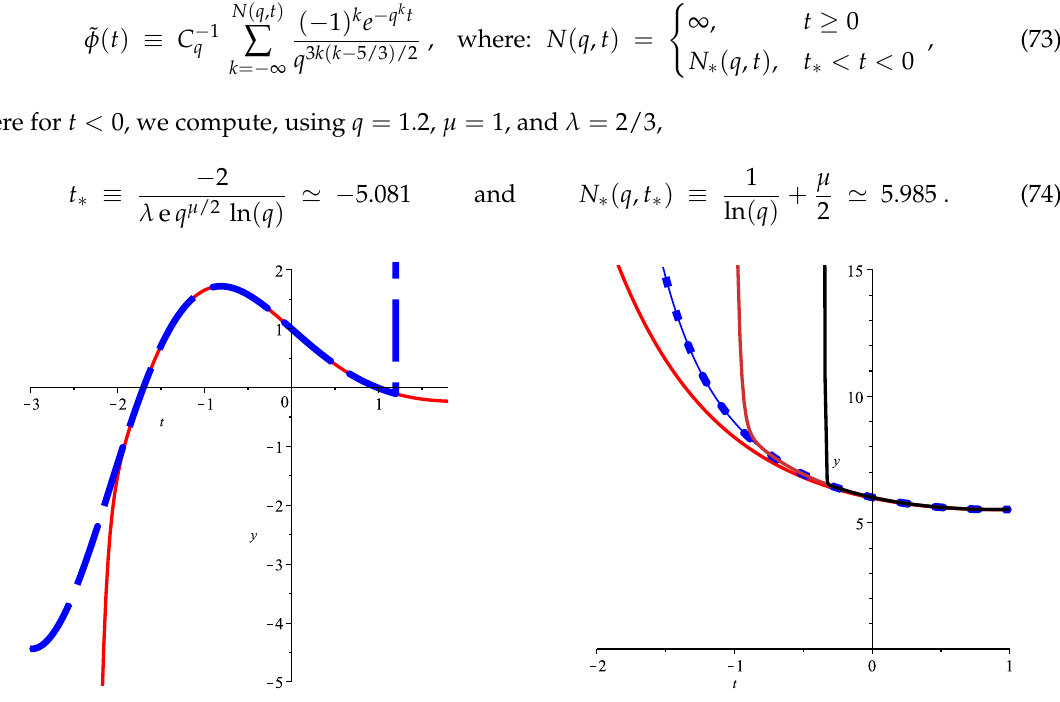
Figure 2. ( Left ) Asymptotic extension ˜ φ ( t ) from Equation (73) for φ ( t ) (solid red) together with a similarly constructed asymptotic extension for − χ ( − ∞ ,0 ] ( t ) W 1,5/3 ( t ) / f (cid:48) q = 1.2. ( Right ) Plots of e t ˜ K ( t ) where the functions ˜ K ( t ) are defined in Equation (76) for q = 1.2. Failure of the asymptotic extension is found to be around t = − 1, as compared to the computed value of t ∗ = − 1.8. The upper-sum limits, from left to right, are N ∗ = 6,10 ( dotted ) ,20,30.